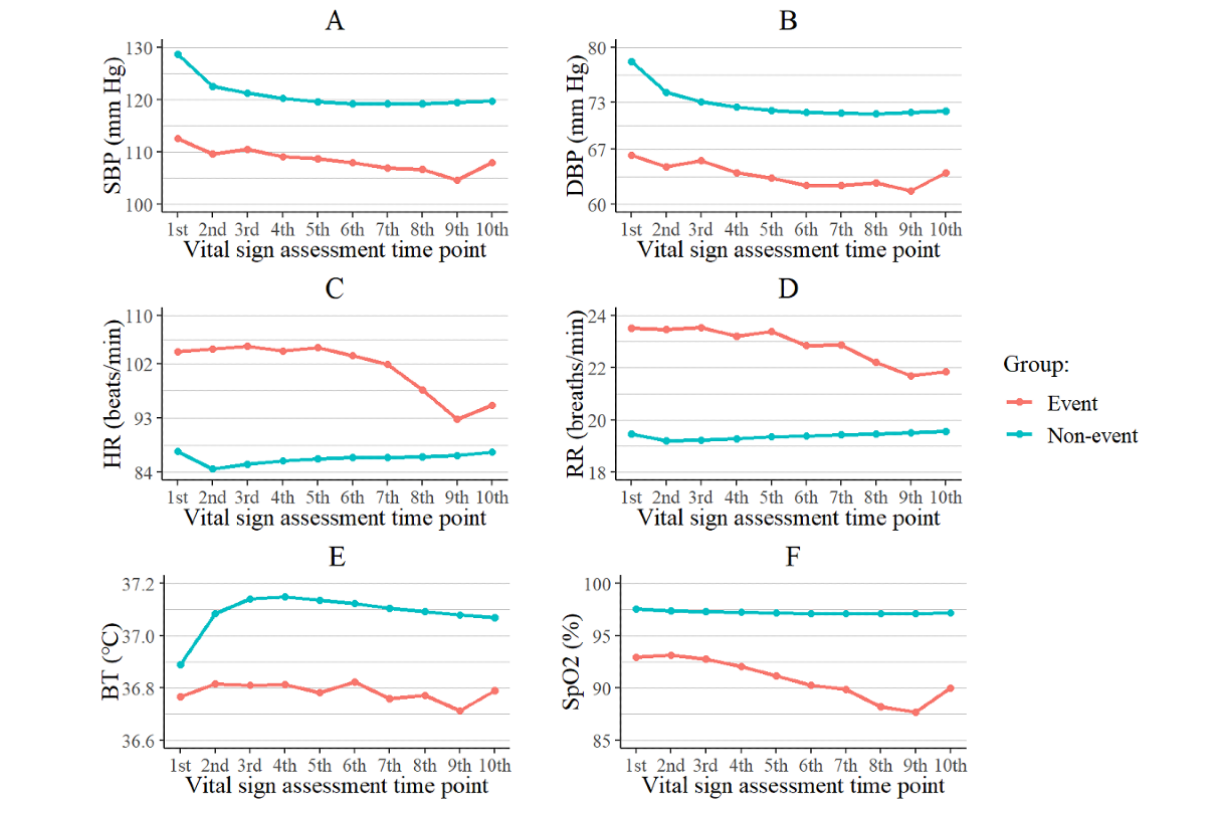
Figure 3. Trends in the event and non-event groups for the vital signs: A. systolic blood pressure; B. diastolic blood pressure; C. heart rate; D. respiratory rate; E. body temperature; F. peripheral oxygen saturation. The x-axis values are the 10 time points before event occurrence, and the y-axis values are the mean values of the vital signs. BT: body temperature; DBP: diastolic blood pressure; HR: heart rate; RR: respiratory rate; SBP: systolic blood pressure; SpO 2 : peripheral oxygen saturation.